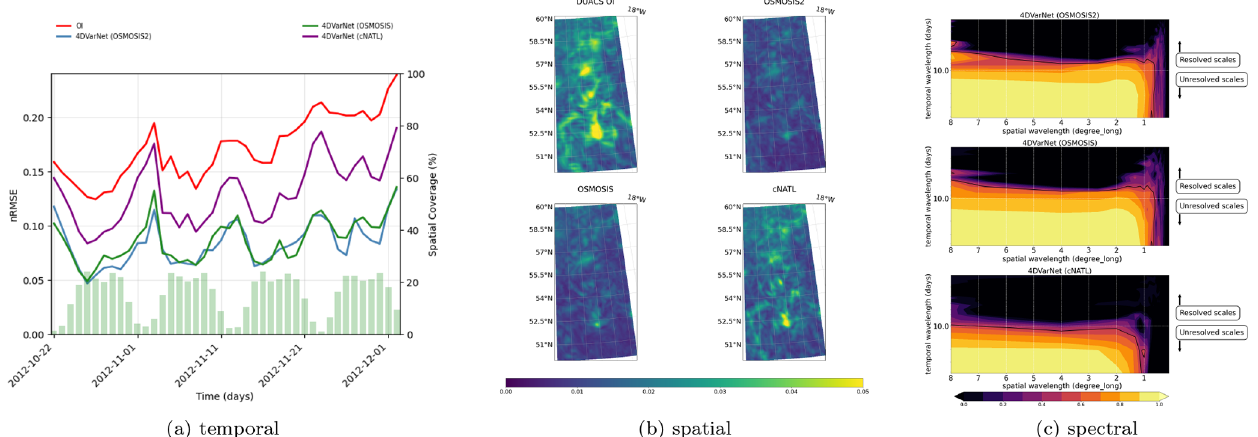
Figure B5. 4DVarNet generalization capabilities (OSMOSIS2), with the spatial, temporal, and spectral performance on the BOOST-SWOT DC evaluation period, based on the three different training domains of OSMOSIS2, OSMOSIS, and